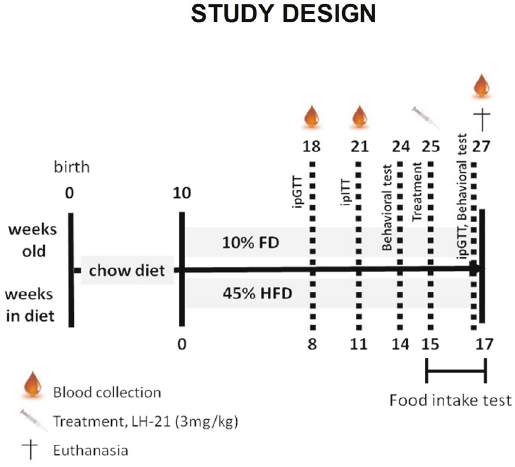
Figure 1. Study design. Outline representing the design of the present study. Drawings are under Creative Commons license CC0 from